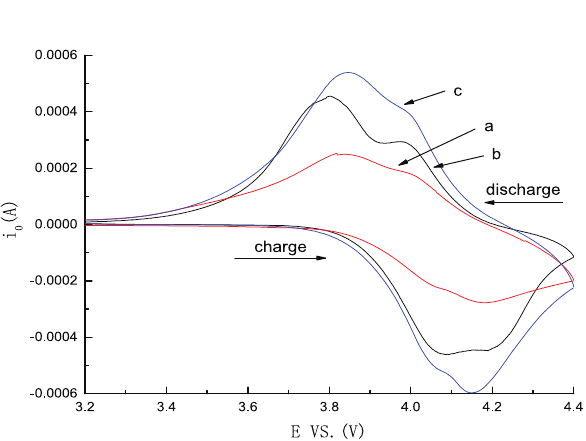
Fig. 4: Charge-discharge curves of samples at 0.5C in the voltage range of 3.20–4.35 V vs. Li/Li + (a: 0 wt% carbon black coated, b: 2 wt% carbon black coated. c: 4 wt% carbon black